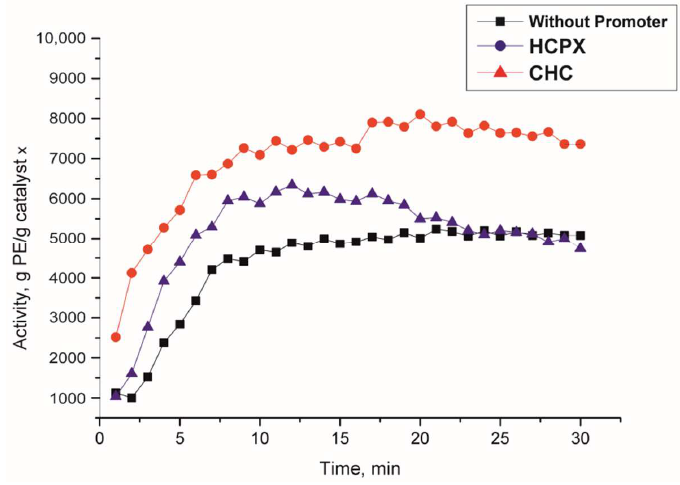
Figure 2. Activity of the catalytic system in ethylene/1-hexene copolymerization as a function of process duration. [1-hexene] = 0.16 mol/L. 2—TMC; 8—TMC–HCPX; 5—TMC–CHC. The conditions are listed in Table 1.